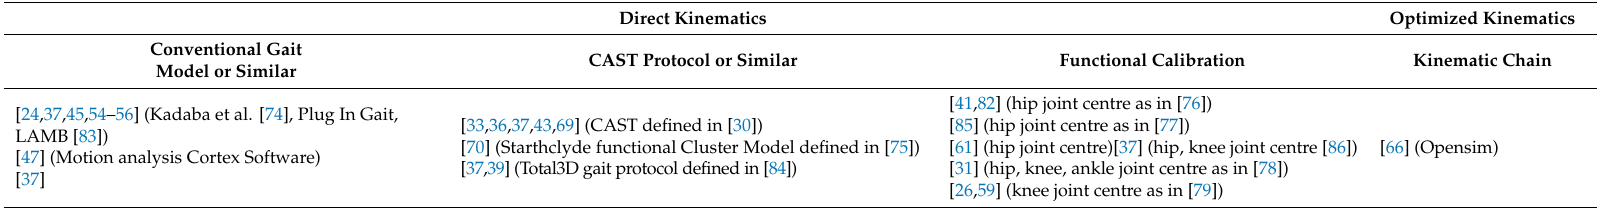
Table 3. Protocols and models used to obtain the segment-coordinate systems with the optoelectronic reference systems.